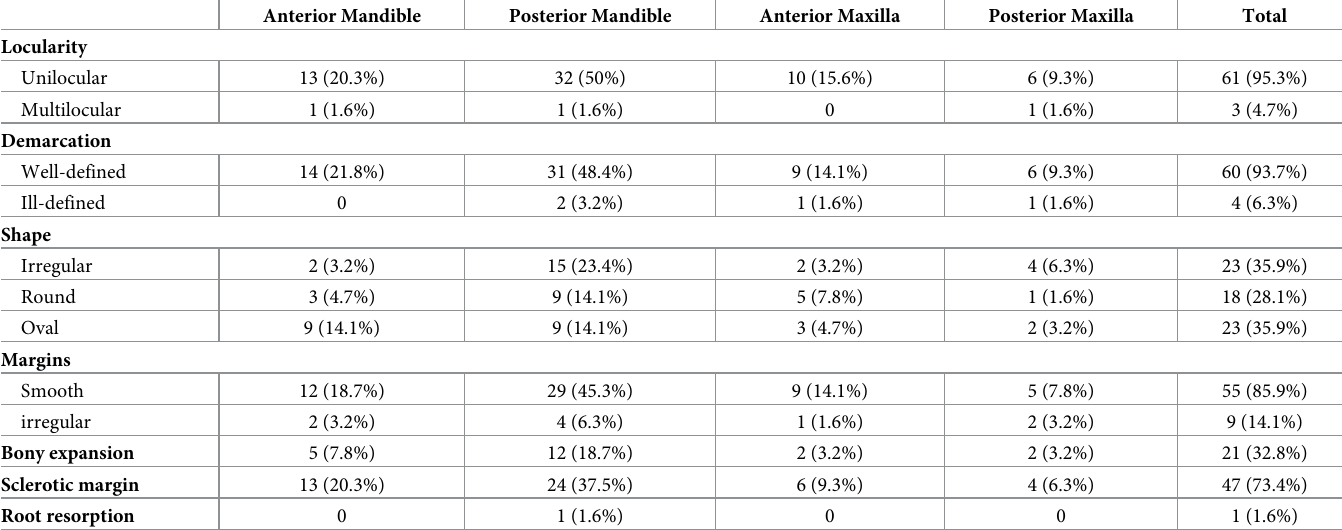
Table 1. Summary of radiological findings of residual cysts of the jaws.